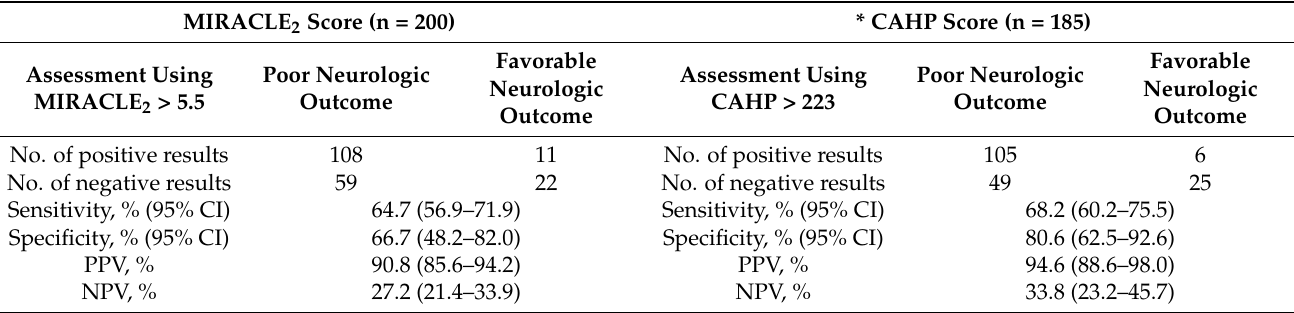
Table 5. Sensitivity, specificity, positive predictive value, and negative predictive value of the risk scores for favorable neurologic outcome of